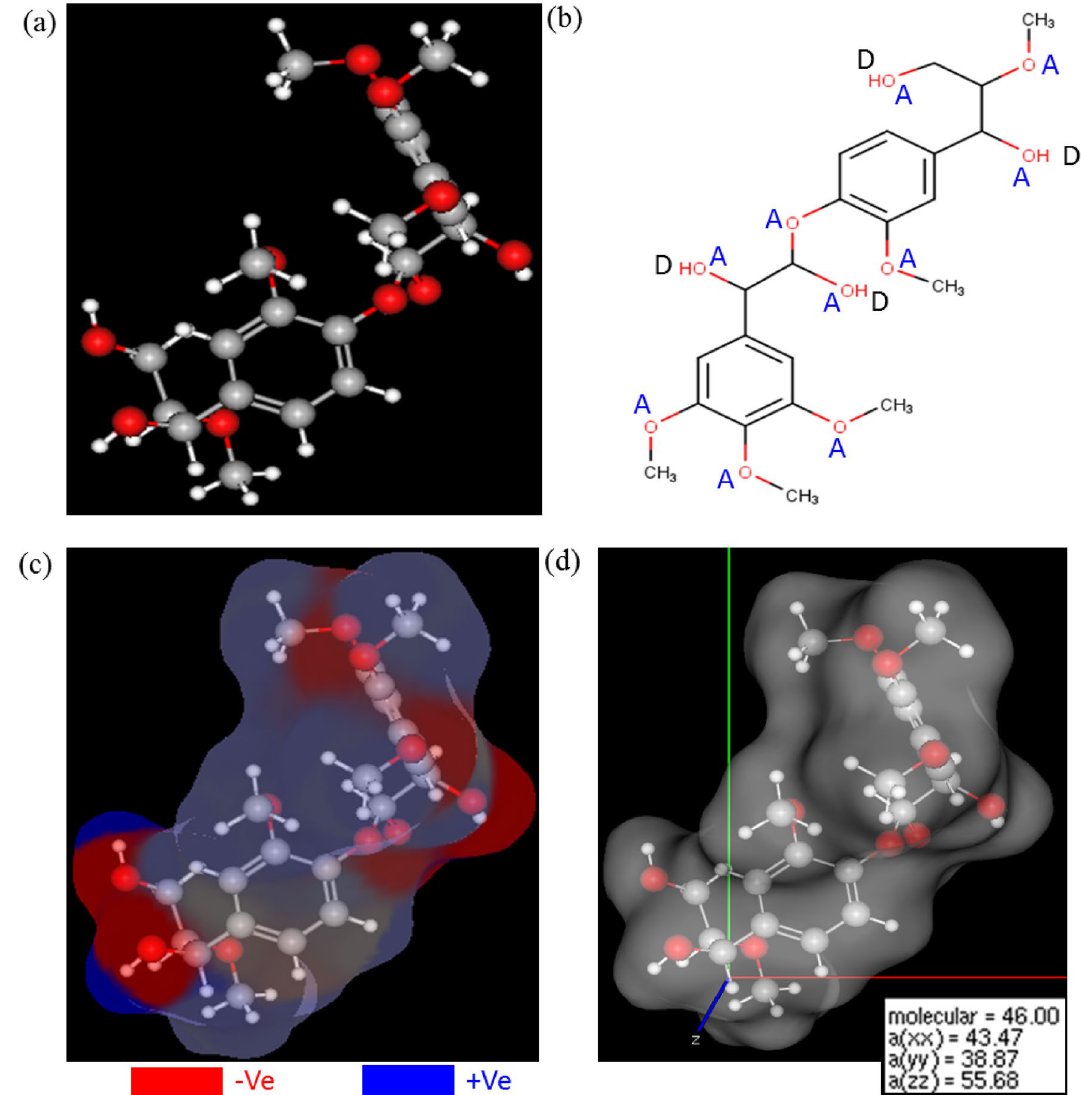
Figure 4. Model unit of S-lignin (1 ‐ {4 ‐ [1,2 ‐ dihydroxy ‐ 2 ‐ (3,4,5 ‐ trimethoxyphenyl)ethoxy] ‐ 3 ‐ methoxyphenyl} ‐ 2 ‐ methoxypropane ‐ 1,3 ‐ diol) ( a ); the figure shows the presence of hydrogen bond acceptors and donors ( b ), the charge distribution ( c ) and molecular polarizabilities ( d ) on s-lignin